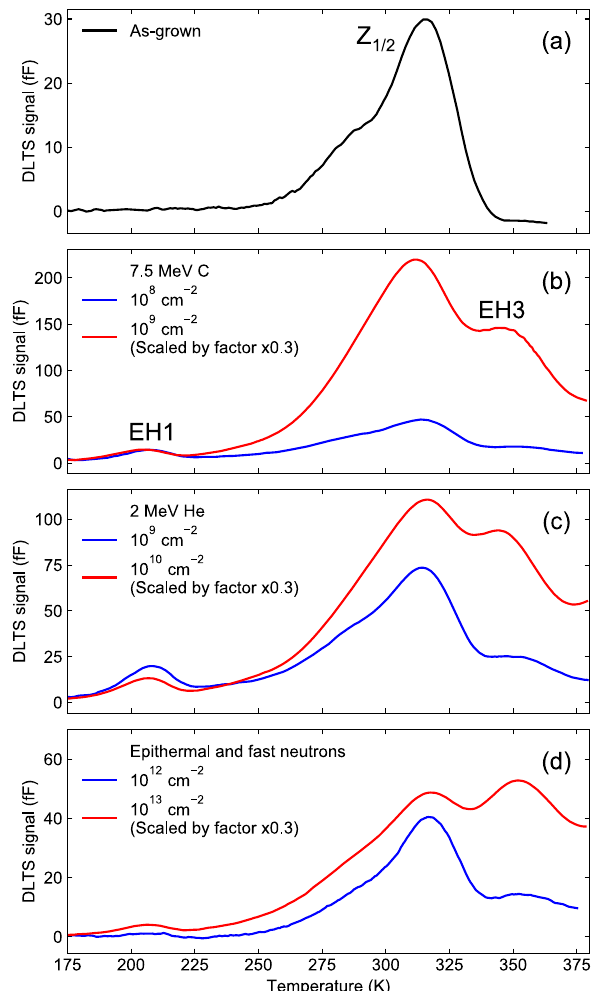
Figure 3. DLTS spectra of as-grown, C and He ion implanted, and neutron irradiated SBDs. The voltage settings for the ion implanted SBDs ( b , c ) reverse bias V R = − 3 V and pulse bias V P = − 0.1 V are chosen to probe the depth region below the ion depth range. In the case of as-grown and neutron irradiated SBDs ( a , d ), the reverse bias and pulse bias are V R = − 10 V and V P = − 0.1 V. The pulse width is 10 ms. The emission rate is 50 1/s.